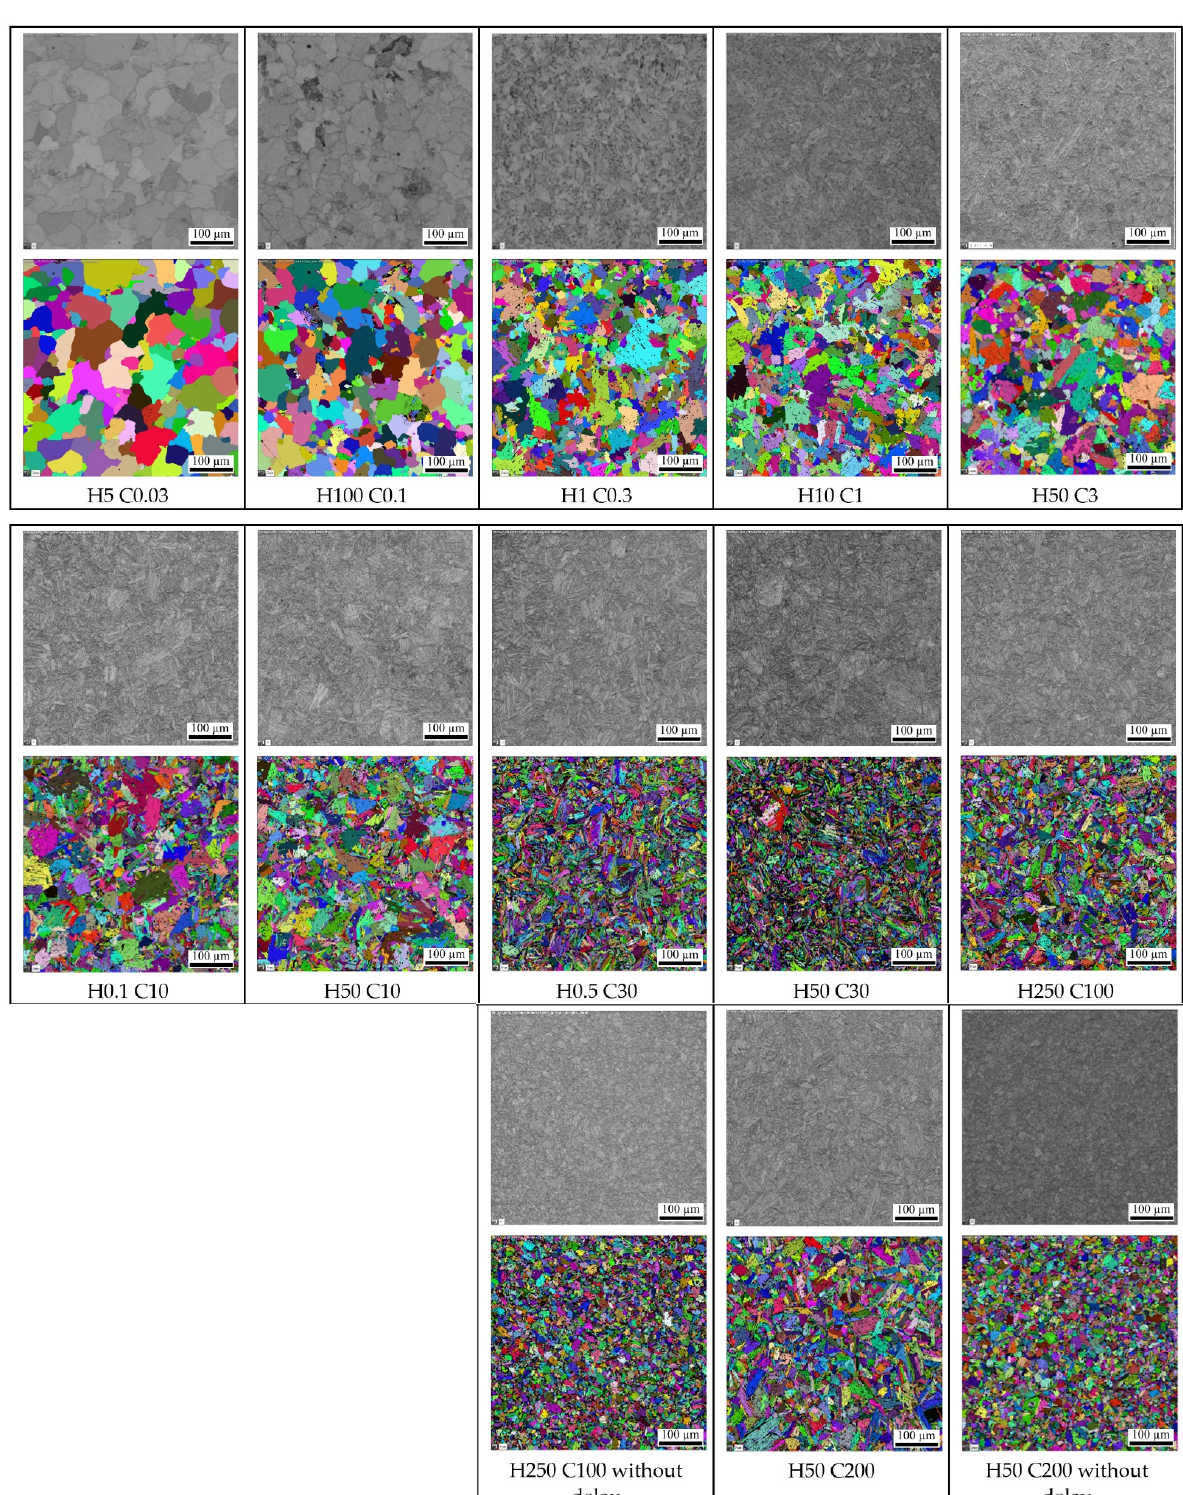
Figure 13. SEM micrographs and EBSD analysis of grain size at different variants of the heating rate and cooling rates.